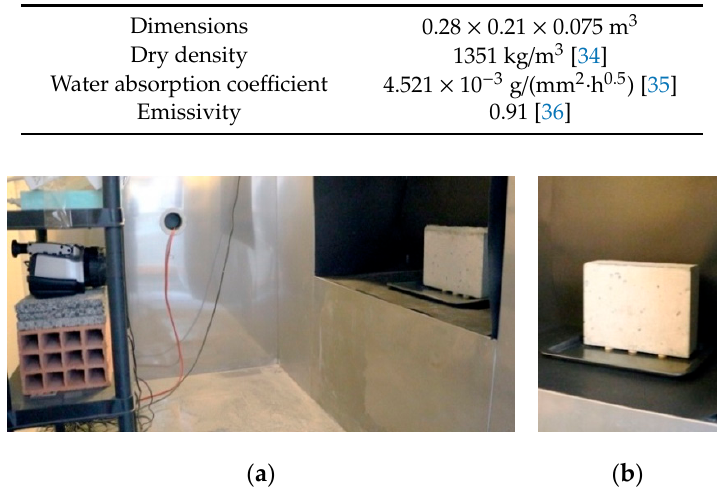
Table 1. Main characteristics of the lightweight concrete under study (measured).